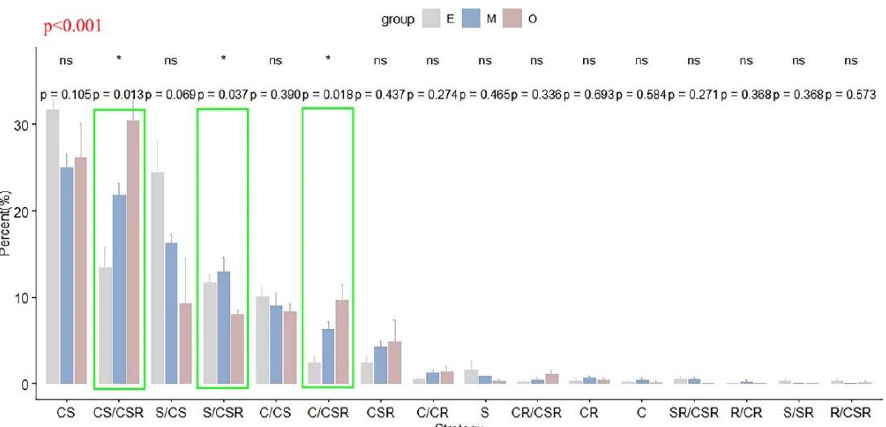
Figure 2. Changes in the ecological strategy spectra (based on CSR theory) across successional stages in the tropical lowland rainforest of Hainan Island (gray, E, early succession; blue, M, mid-succession; and red, O, late succession). Percentages (%) indicate the average number of species in each strategy category ( n = 4), with error bars denoting the standard errors. * indicates a significant difference among stages ( p < 0.05), while ns indicates no significant difference ( p > 0.05); green boxes additionally highlight significant cases. p < 0.001 in the top left indicates a significant difference among the ecological strategy spectra of three succession stages.